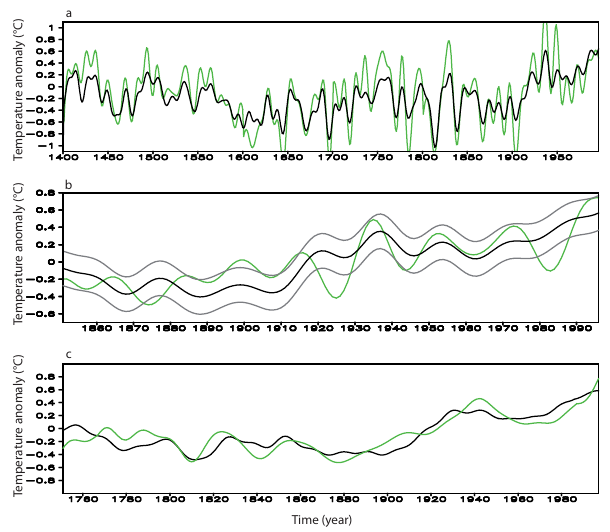
Fig. 1. Time series ( ◦ C) of the anomaly in annual mean surface temperature averaged over the 11 simulations using DA (black) for Scandinavia (defined here as the region 5 ◦ –35 ◦ E, and 55–75 ◦ N) and (a) the average of the 6 proxies used to constrain model re- sults in this region (green), (b) the instrumental data compiled in the HadCRUT3 data set (green, Brohan et al., 2006), and (c) the av- erage over Stockholm and Uppsala long instrumental time series, (Moberg et al., 2003). For (a), model results are averaged only over the points where proxy data are available. Reference period is 1850–1995. All the time series have been decadally smoothed. A 21-year running mean has been applied for panel